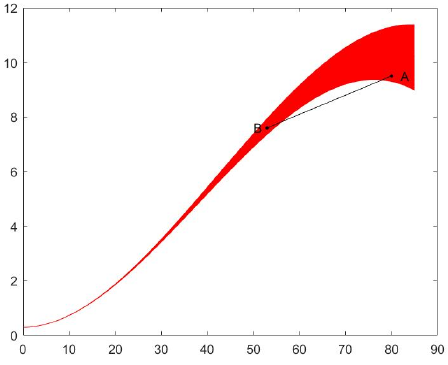
Figure 1. An example of a non-convex set.